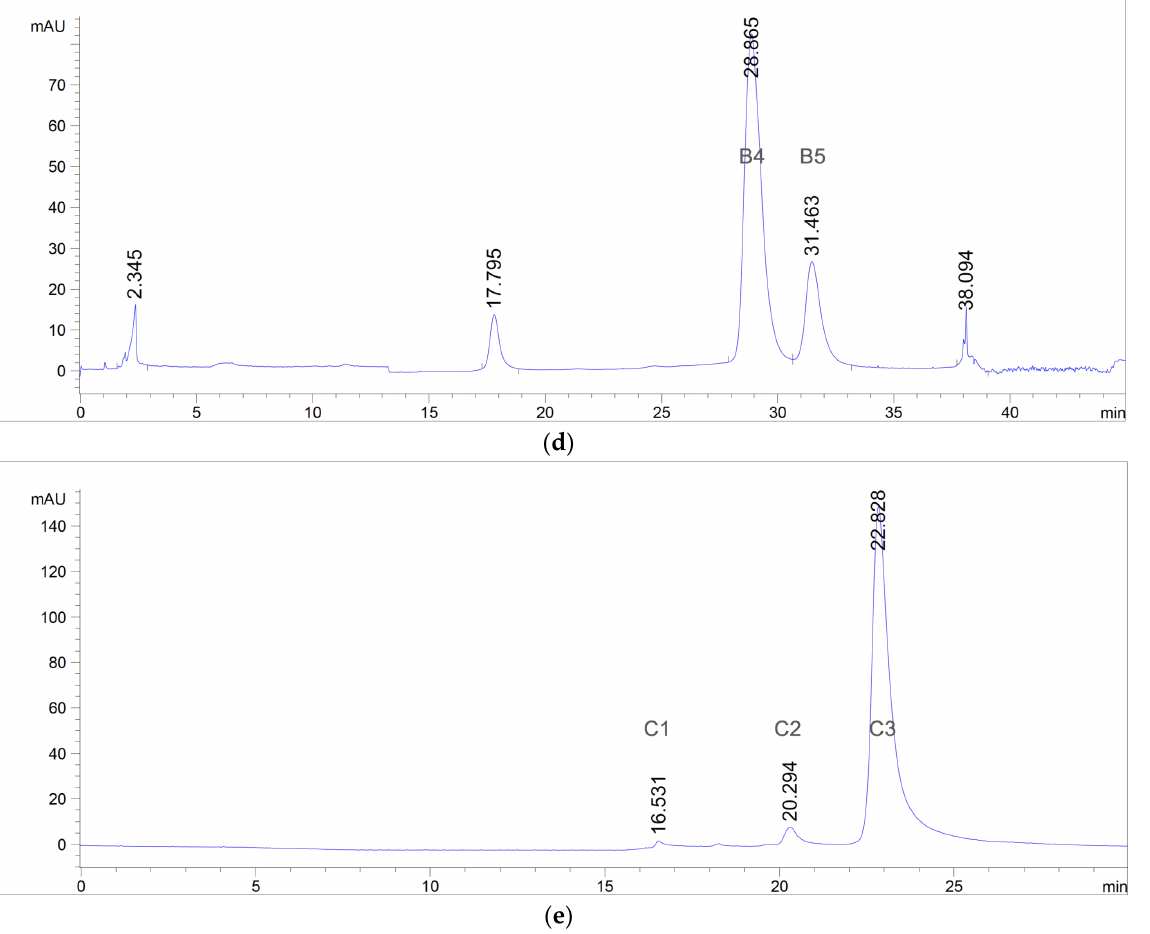
Figure 1. ( a ) UV chromatogram of all fractions under preparative RP-HPLC isolation conditions. The first minor fractions were pooled, whereas subfractions A–E were individually collected, followed